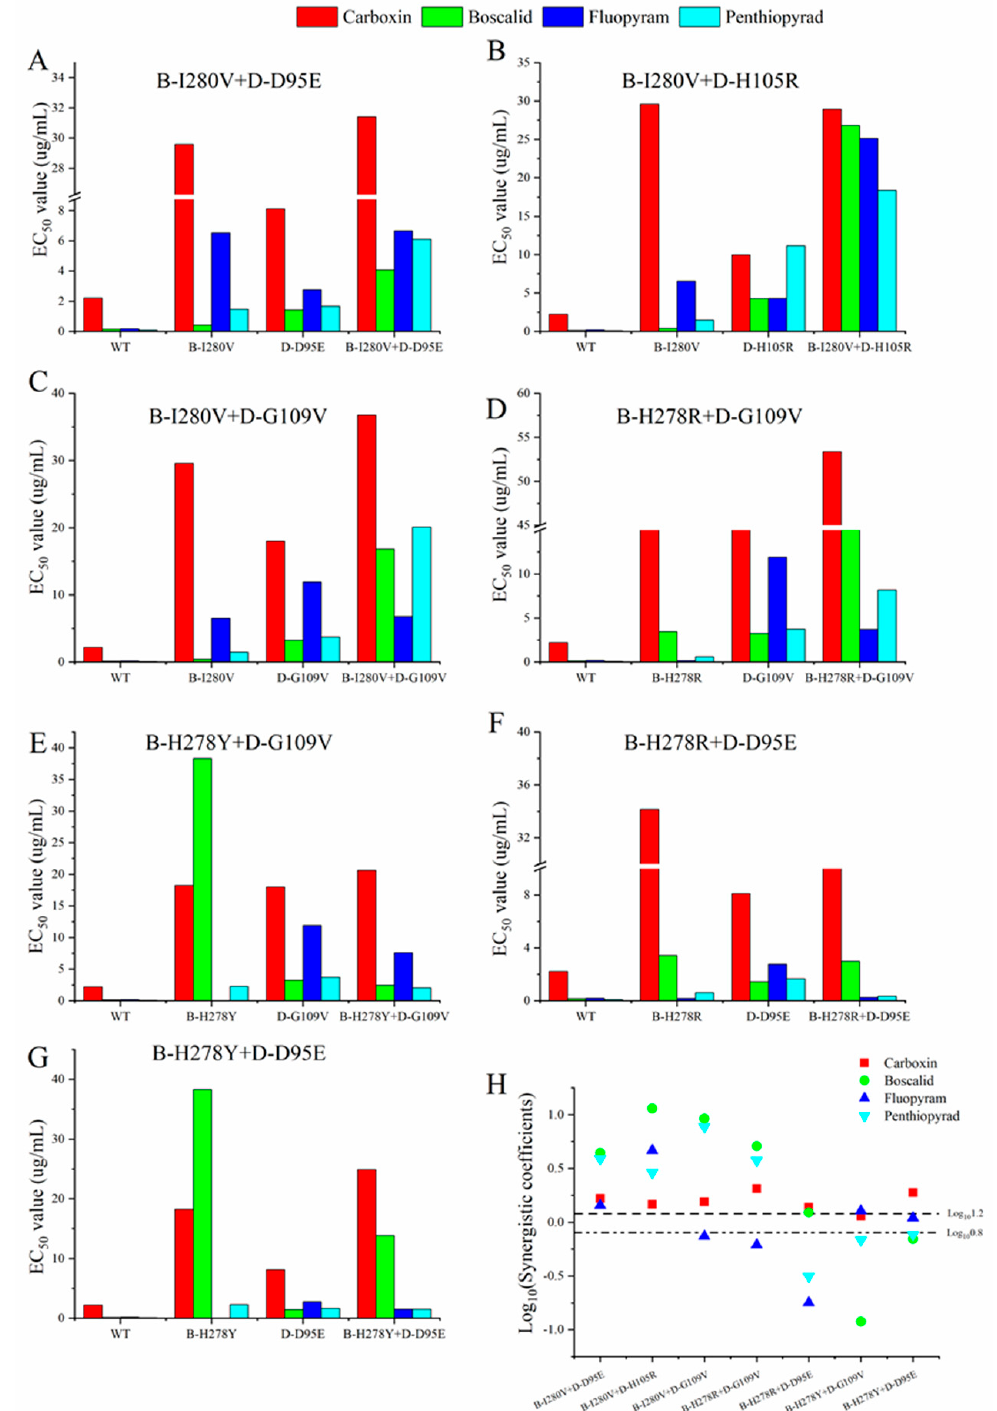
Figure 2. Comparison of SDHI resistance among the C. cassiicola wild-type and single or double mutation. ( A – G ) comparison of EC 50 values of single and double mutation sensitivities. ( H ) comparison of synergistic coefficients of the double mutations. The synergistic coefficients were expressed on a Log 10